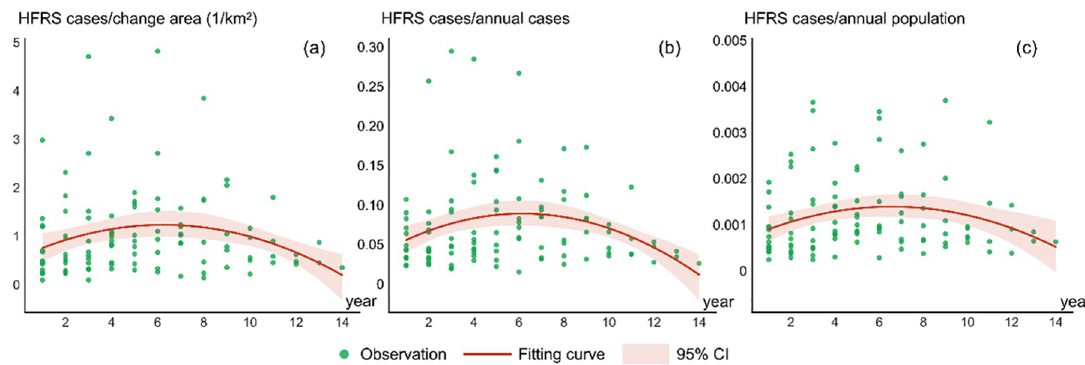
Fig 5. Relationships between urbanization and incidence rate of HFRS. Number of HFRS cases (a) divided by the transformed urbanized area in Xi’an, (b) divided by its total annual population within the changed area in Xi’an, and (c) divided by the total HFRS cases within the changed area in